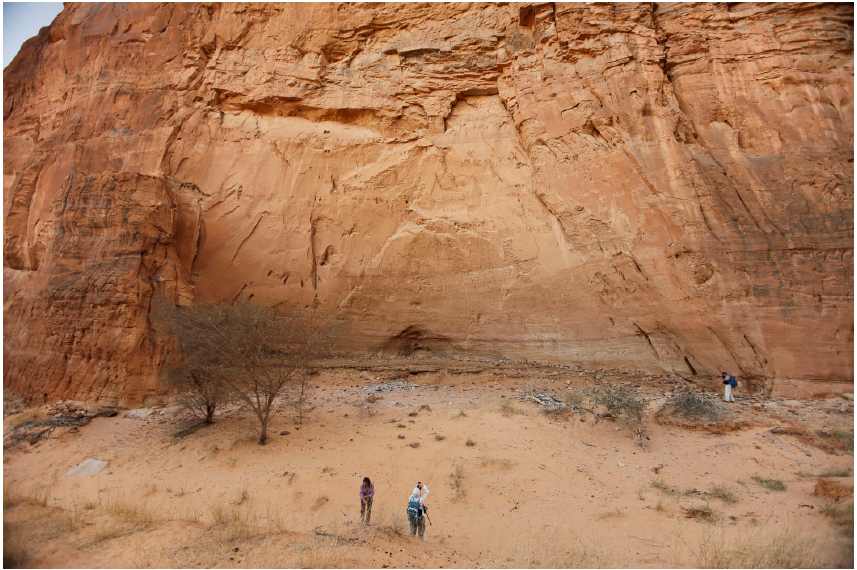
Figure 2. View of the Nabara 2 shelter from the dune bordering the Saodomanga hill to the north (Photo: Alessandro Menardi Noguera).